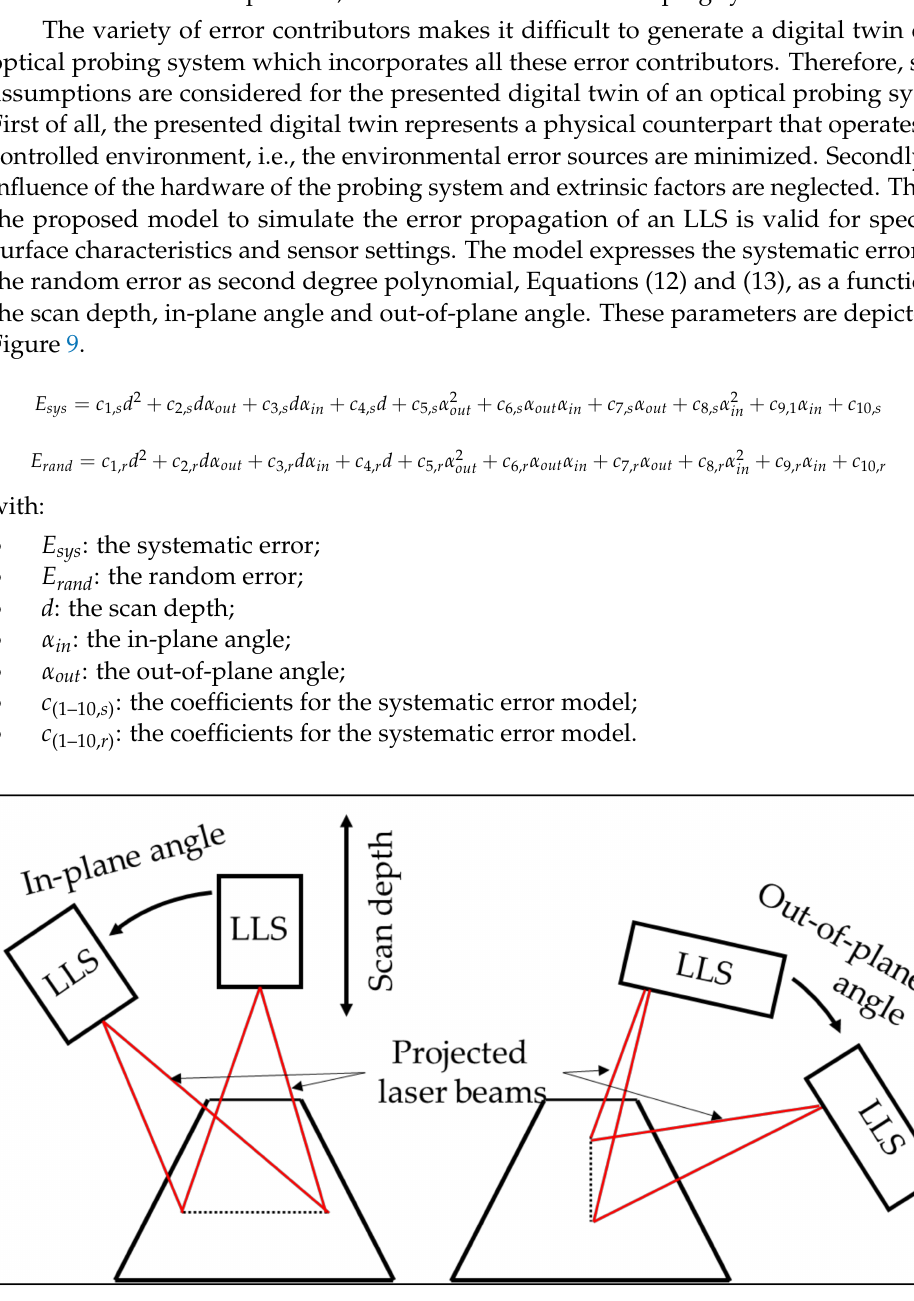
Figure 9. Scan depth, in-plane angle and out-of-plane angle of an LLS based on